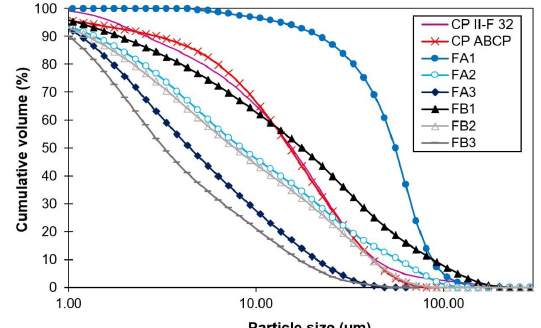
Figure 1. Particle size distribution of cements and GRF